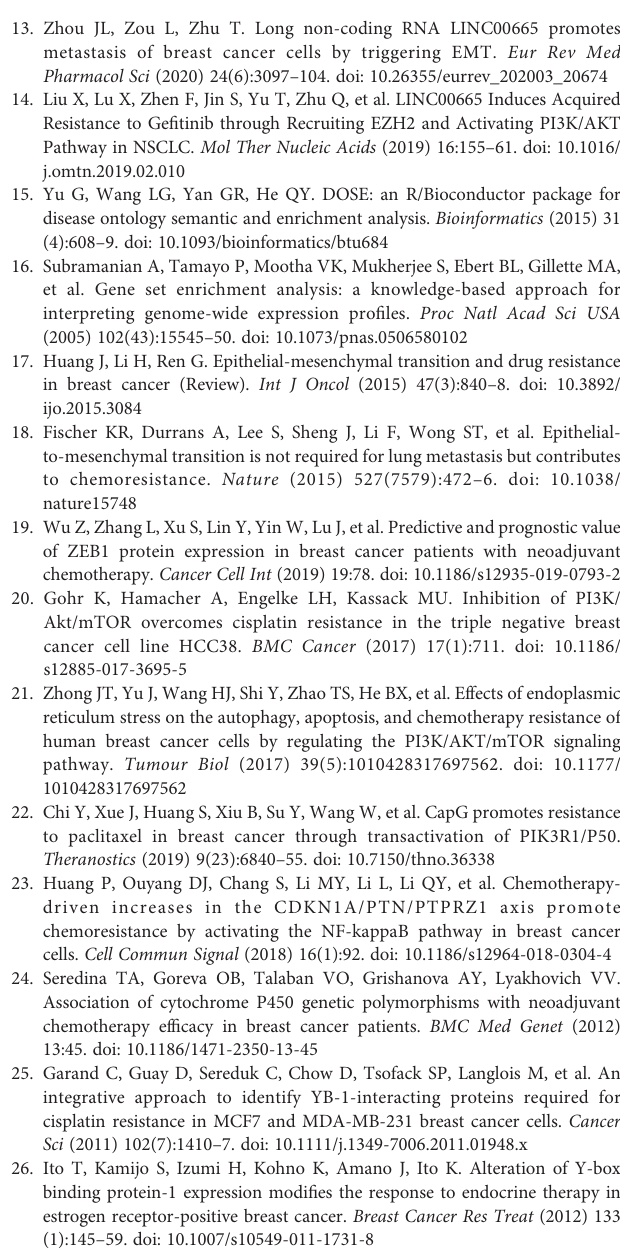
Supplementary Figure 1 | Association between Linc00665 expression and lymph node status in The Cancer Genome Atlas (TCGA)